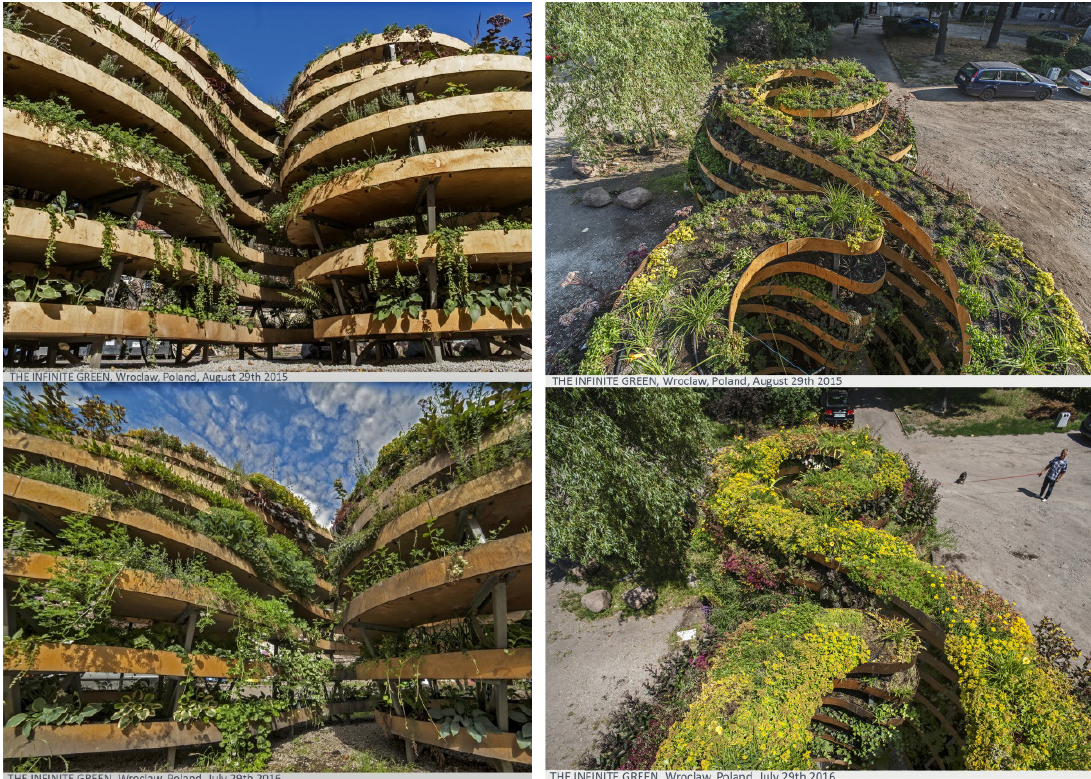
Figure 4. Growth of plants in one year: ( up ) photos were taken in August 2015, ( bottom ) photos in July 2016. Reproduced with permission from [57]; 2020, Adam Kalinowski (http://adamkalinowski.com).